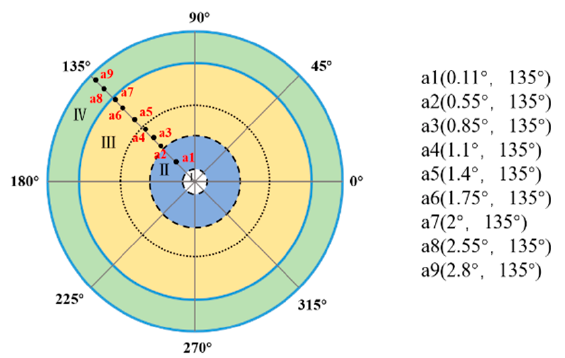
Figure 11. Nine simulated target positions.